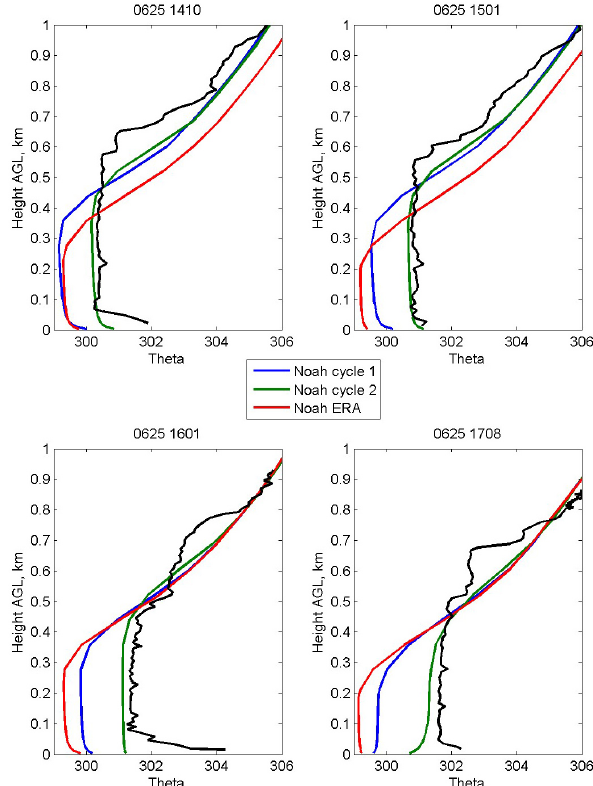
Figure 9. Potential temperature profiles observed by four frequent soundings at BLLAST site 2 on 25 June 2011 (black) and simula- tions as shown in the legend. Model results are from the nearest grid